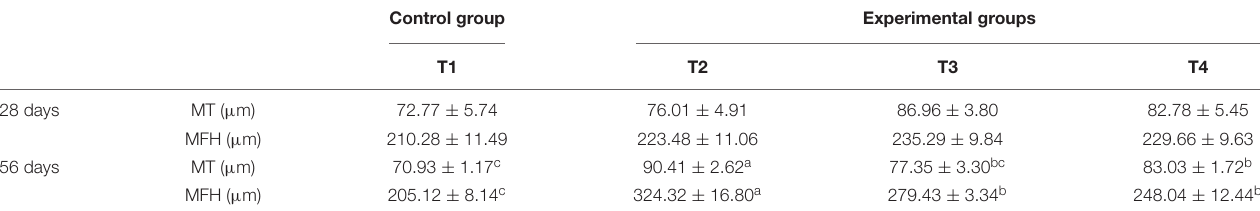
TABLE 6 | Effects of autochthonous probiotics on anterior intestinal morphology of grouper ( E. coioides ) fed diets with high levels of histamine.